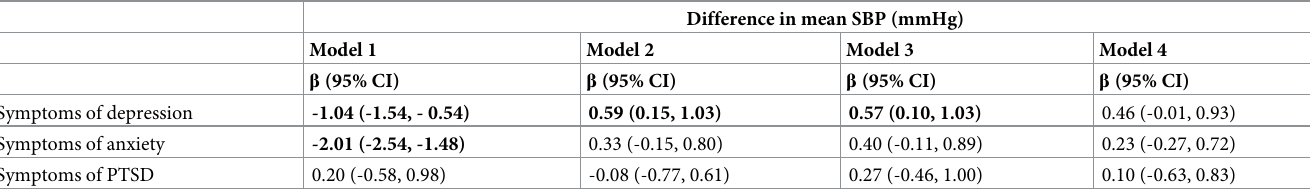
Table 3. Associations between systolic blood pressure across probable mental disorders.